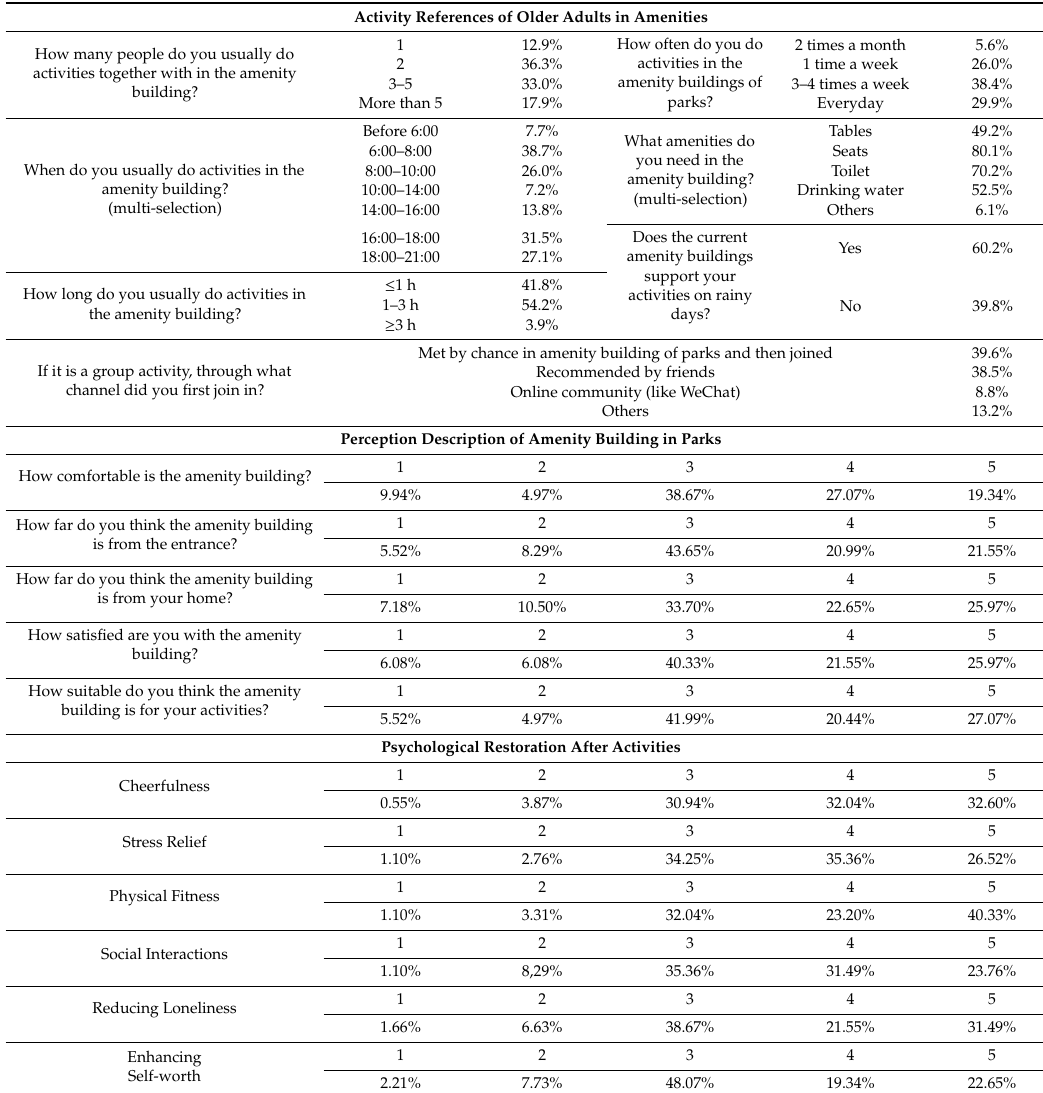
Table A1. Questionnaire contents and statistical